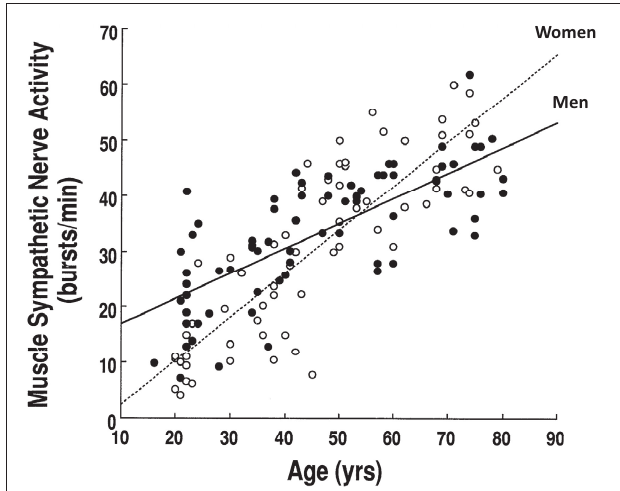
FIGURE 1 | Resting muscle sympathetic nerve activity increases with age and the increment is greater in women than in men. Adapted with permission from Matsukawa et al. (1998b).